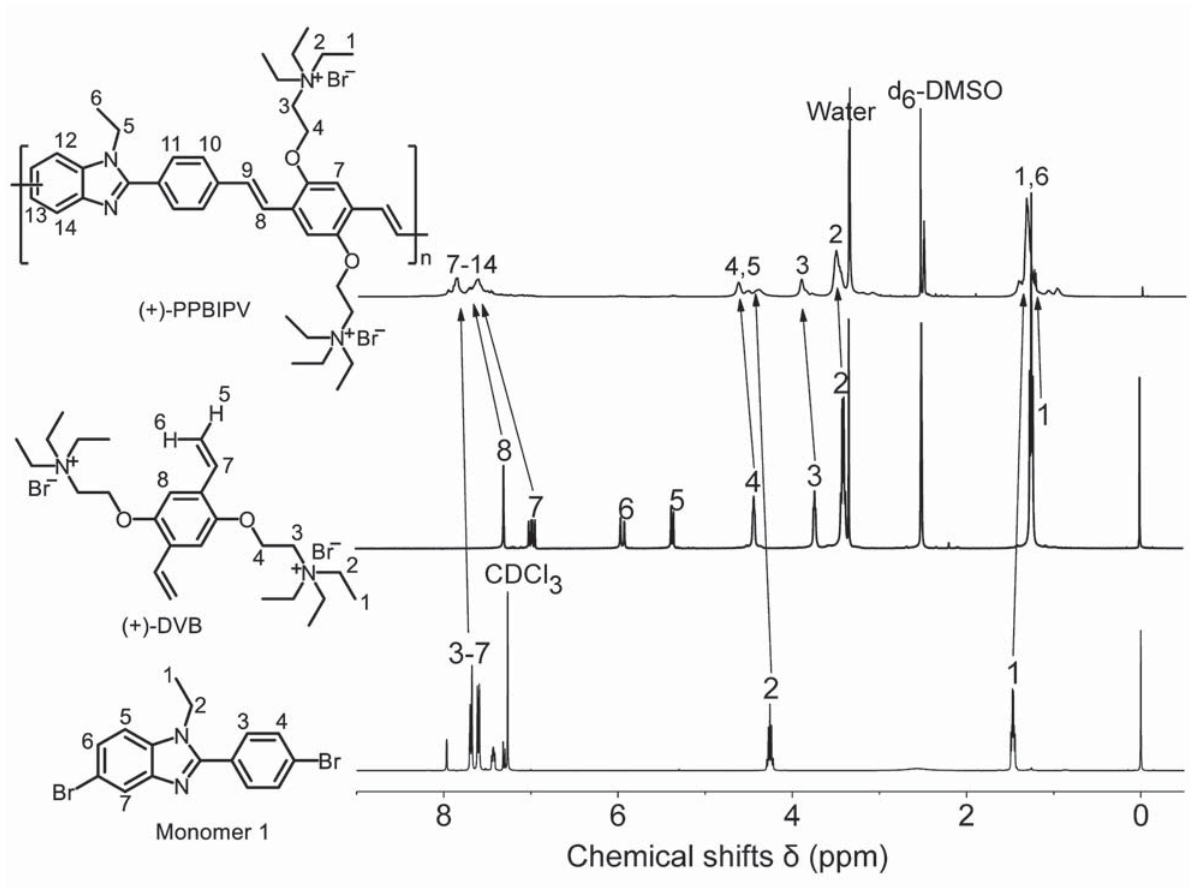
Figure 1: 1 H NMR spectra of monomer 1, (+)-DVB and